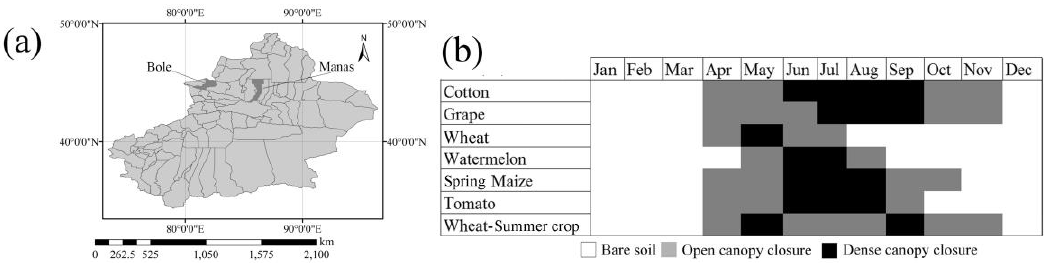
Figure 1. ( a ) The extent of Xinjiang and the locations of the study areas of this study; and ( b ) vegetation cover fractions for different crop types over the course of a year.